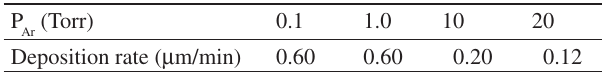
Table 2. Deposition rate of CdTe films deposited at T under different argon pressures.